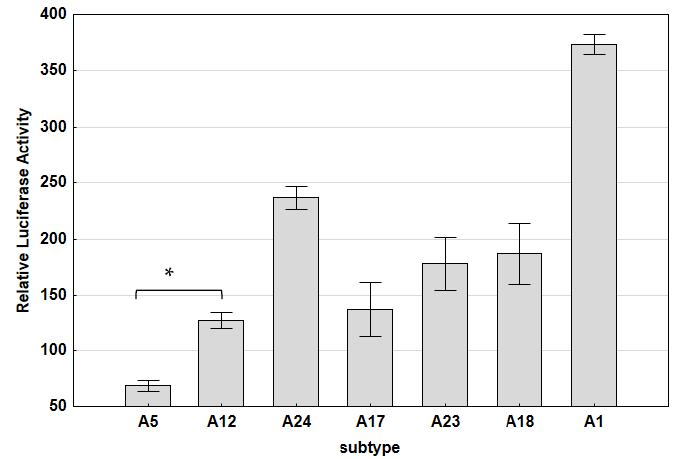
Figure 4. Subtype-specific transcriptional activity of Polish SRLV LTR variants in TIGEF cells. Dif- ferential activity of the SRLV LTR variants representing subtypes A1, A5, A12, A17, A18, A23 and A24. Results present the mean of independent transfection experiments, and standard deviations are shown as error bars. The asterisk indicates a significant difference ( p < 0.05) according the Mann– Whitney U test. Subtypes A1, A17, A18, A23 and A24 were not included in the inter-subtype analysis due to limited samples (<5) representing each subtype.